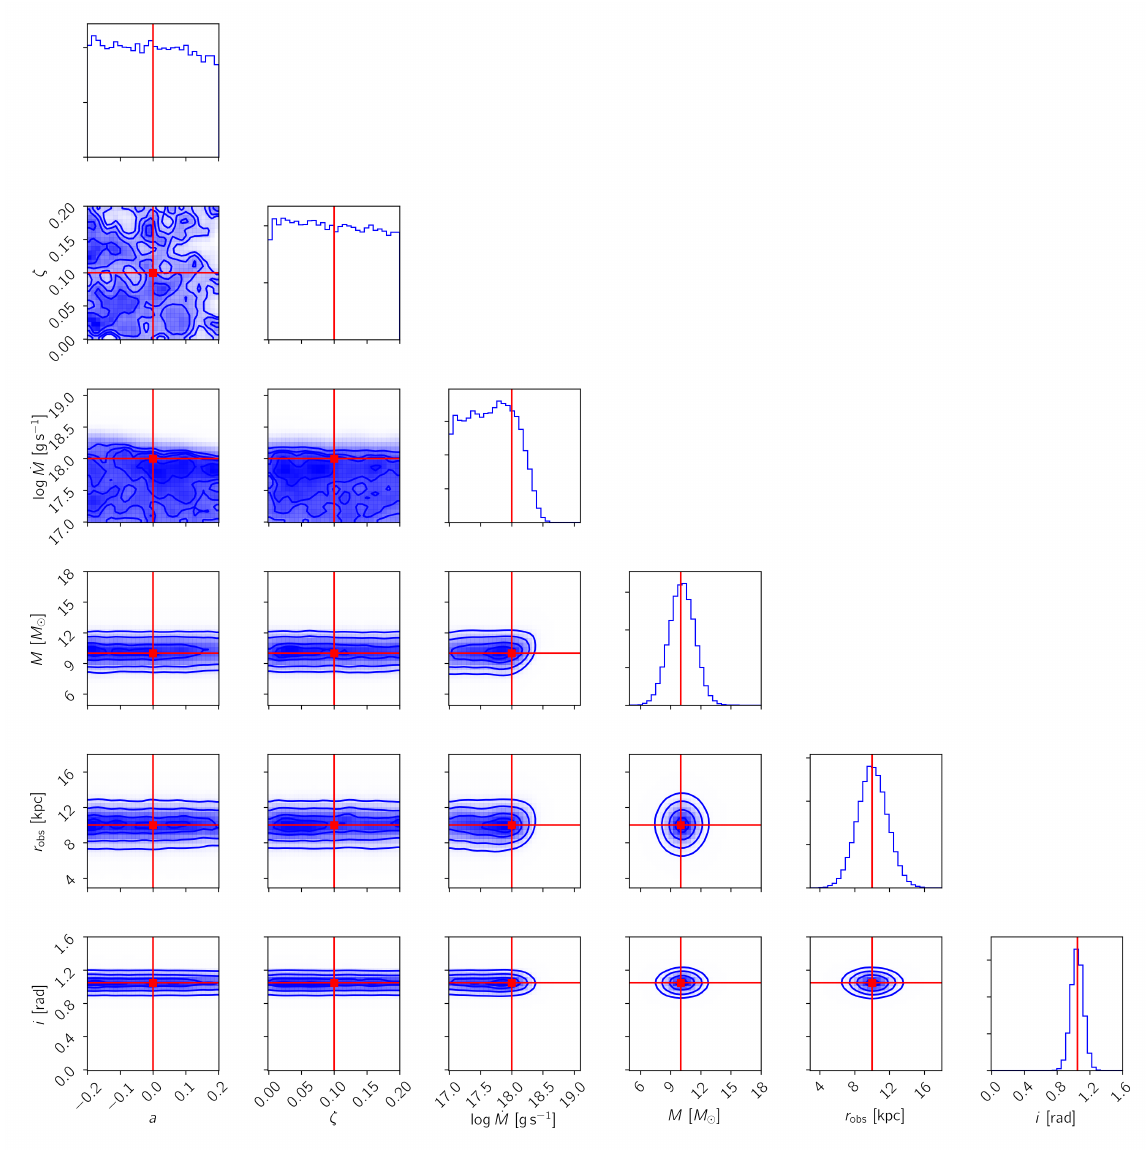
Figure 2. Results of the MCMC analysis for case D, where the vertical red lines correspond to the injected values. Similarly, as shown in Figure 1 the parameters M , r Gaussian priors used, and a , ζ and ˙ M are not well estimated due to the large degeneracies between